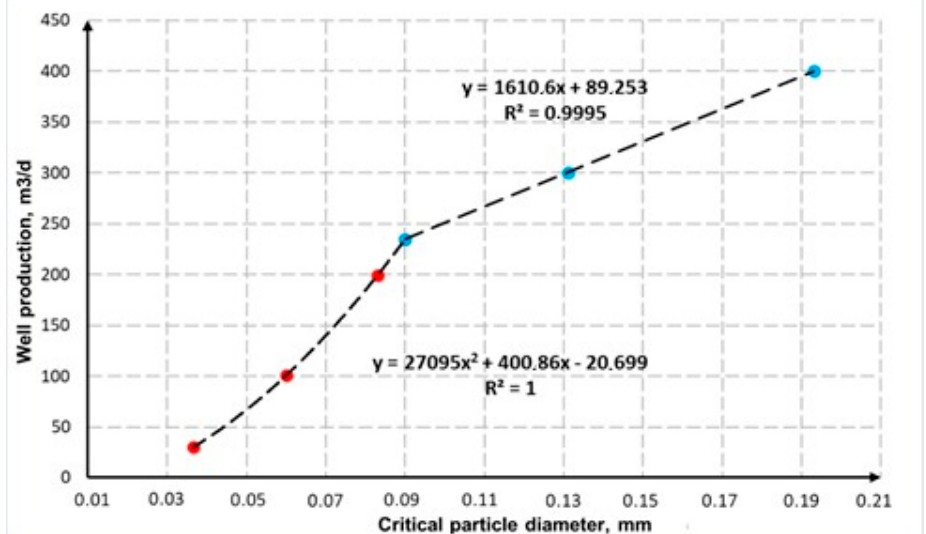
Figure 8. Quality of solid particles recovery by fractions at various well flow